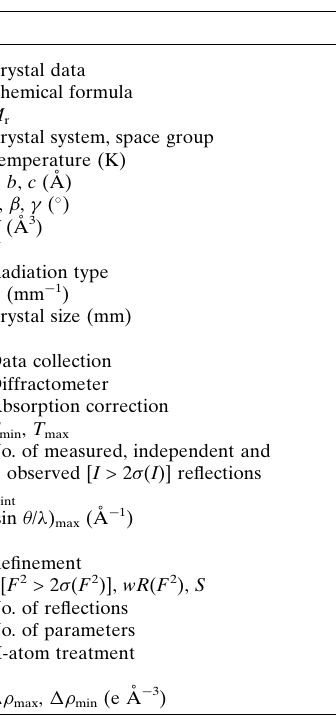
Table 5 Experimental